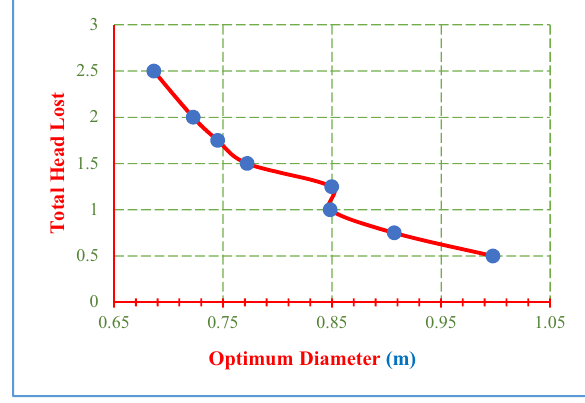
Figure 9: Manning coe ffi cient vs optimum diameter.